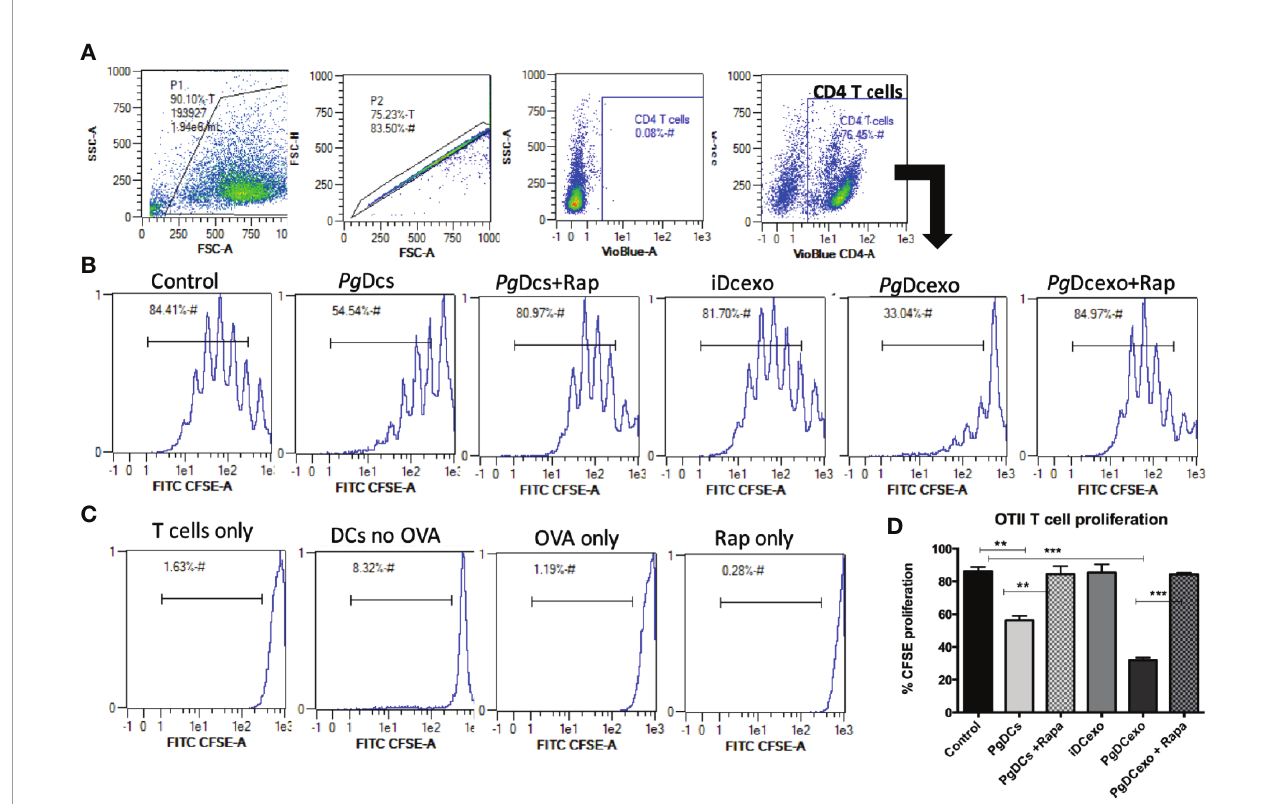
FIGURE 7 | PgDCexo impairs antigen presentation of recipient yDCs: (A) Flow cytometry scatter grams showing Gating strategy. (B) Representative fl ow cytometry histograms showing % proliferation of CFSE labeled splenic ovalbumin speci fi c CD4 T cells from OTII mice co-cultured with pre-treated yDCs. (C) Flow cytometry histograms showing % of CFSE proliferation in negative controls for proliferation which include T cells only, yDC/T cells only, Ova/T cells, and Rap/T cells. (D) Summary bar graphs for fl ow cytometry data shown in (B) . Analysis was done using one-way ANOVA and Tukey multiple comparison post hoc test (Data are expressed as means ± SD, **p<0.01, ***p<0.001). (iDCs), control immature DCs exo; (StimDCexo), Ecoli LPS-stimulated mature DCs exo; (PgDCexo), Pg-infected